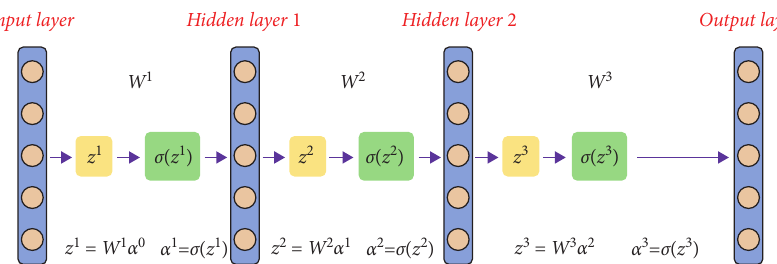
Figure 1: Neural